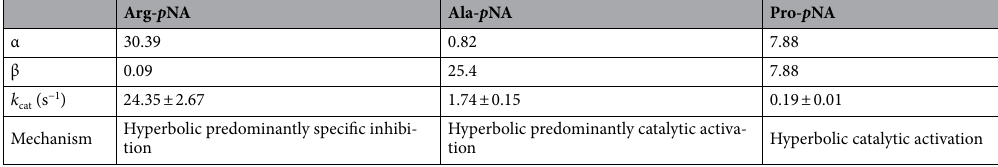
Table 2. Calculated kinetic parameters of each substrate mechanism by LTA 4 H AP